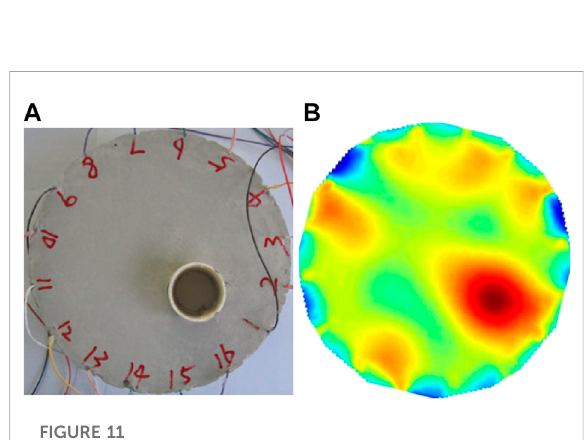
FIGURE 10 Boundary voltage values collected from circular concrete specimens.